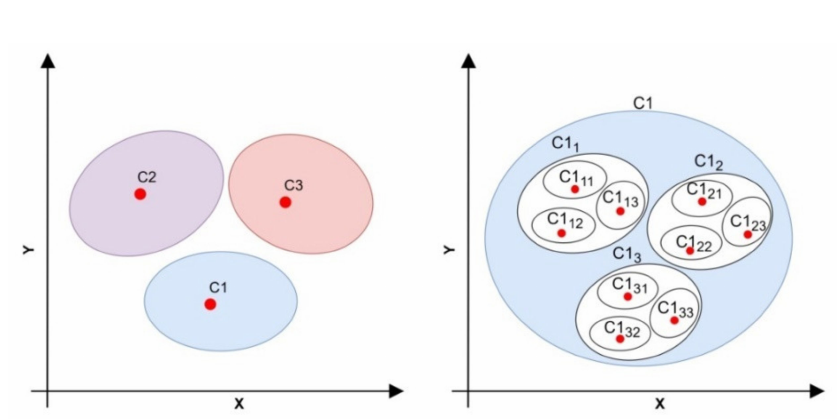
Figure 4. Multi-layers k-means